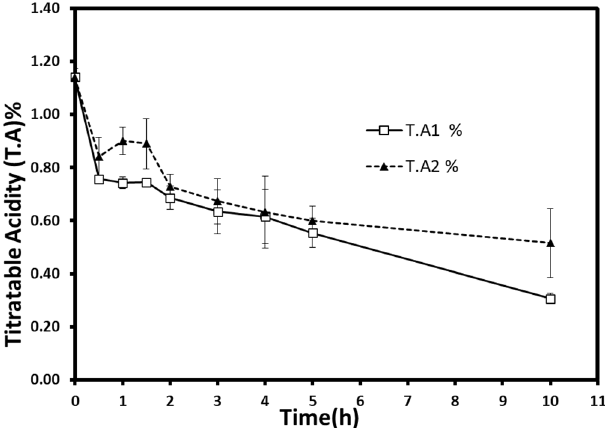
Figure 6. Titratable acidity (malic acid%) evolution during osmotic dehydration at atmospheric (T.A1) and vacuum (T.A2) pressures. Each point represents the mean and standard deviation of a duplicate of three repetitions.